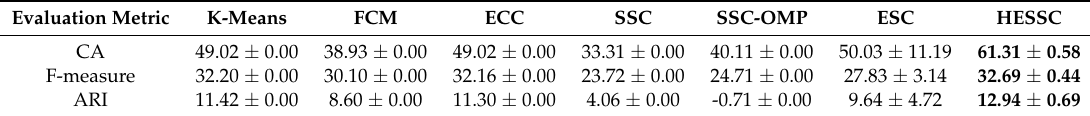
Table 3. Quantitative assessment on the performances of the clustering algorithms applied on the third drill-core sample. The evaluation metrics are reported in mean and standard deviation over 10 trials.